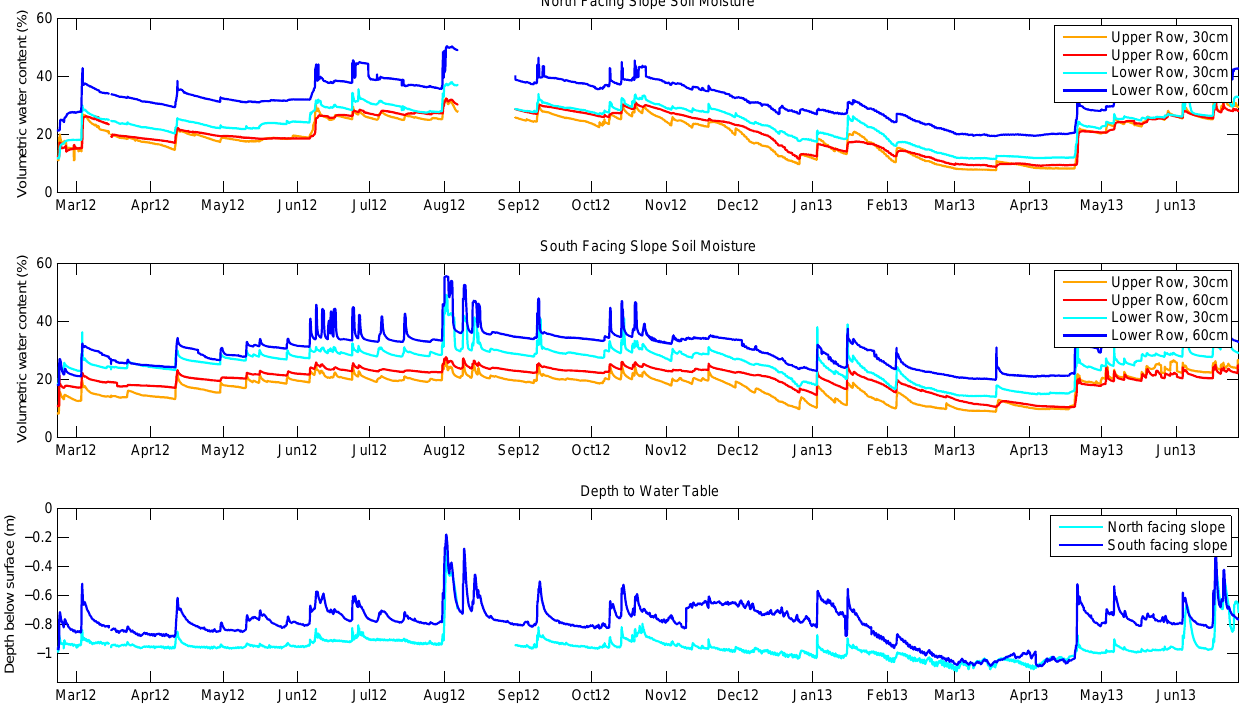
Figure 3. Time series of average soil moisture and groundwater level for the complete study